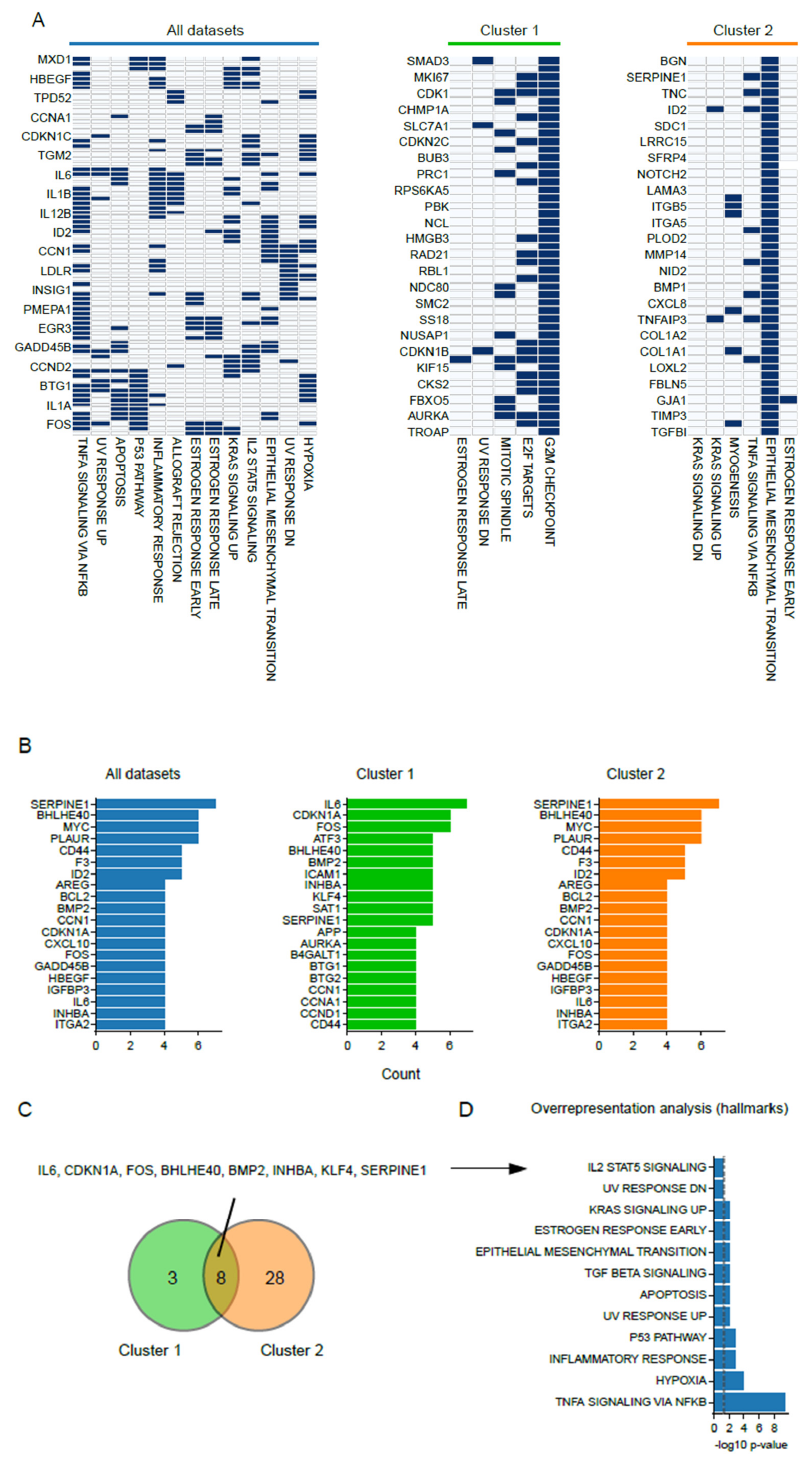
Figure 4. Leading edge analysis reveals commonalities in gene expression profiles. ( A ) Leading edge analysis based on hallmark gene sets that were found to be enriched in the overrepresentation analysis. The analysis was carried out on all datasets, cluster 1, and cluster 2. Genes that appear in a hallmark gene set are marked in blue. ( B ) Top 20 most found genes in the leading edge